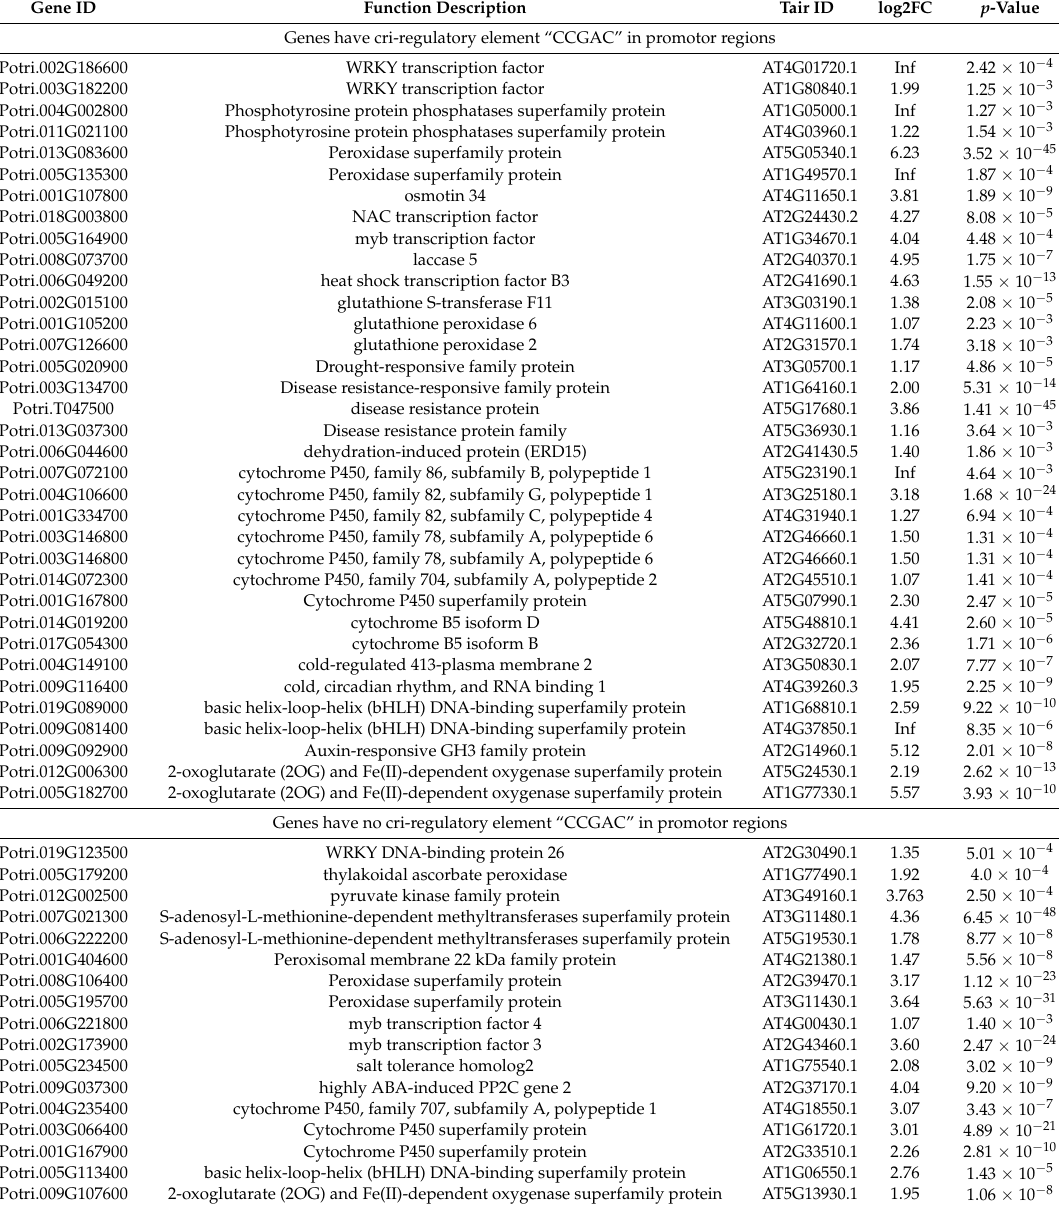
Table 1. Genes associated with stress resistance among up-regulated genes in transgenic poplar. Gene